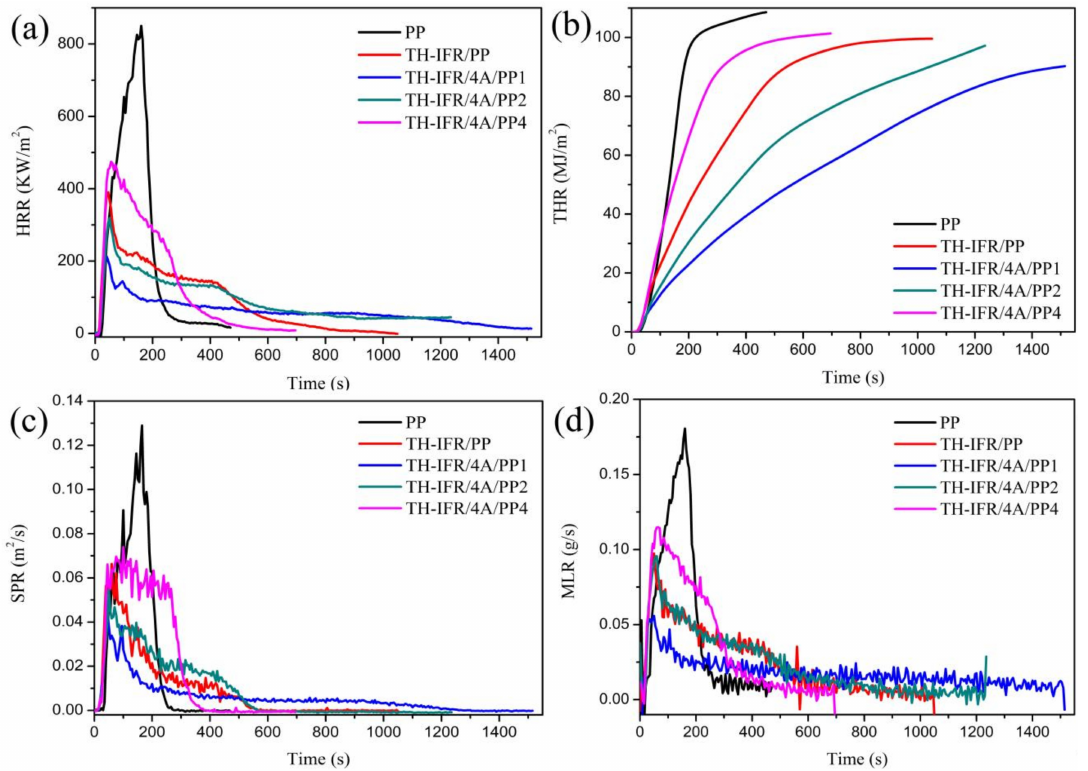
Figure 4. The HRR ( a ), THR ( b ), SPR ( c ) and MLR ( d ) curves of pure PP, TH-IFR/PP, TH-IFR/4A/PP1, TH-IFR/4A/PP2 and TH-IFR/4A/PP4 FR